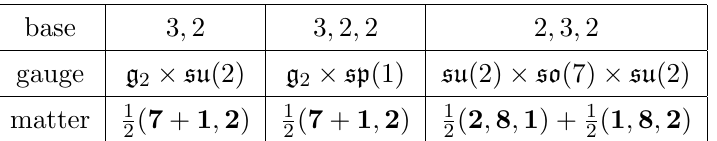
Table 7 . Non-Higgsable clusters with multiple base curves. The (cid:12)rst row of the table represents the negative of the self-intersection numbers of the base